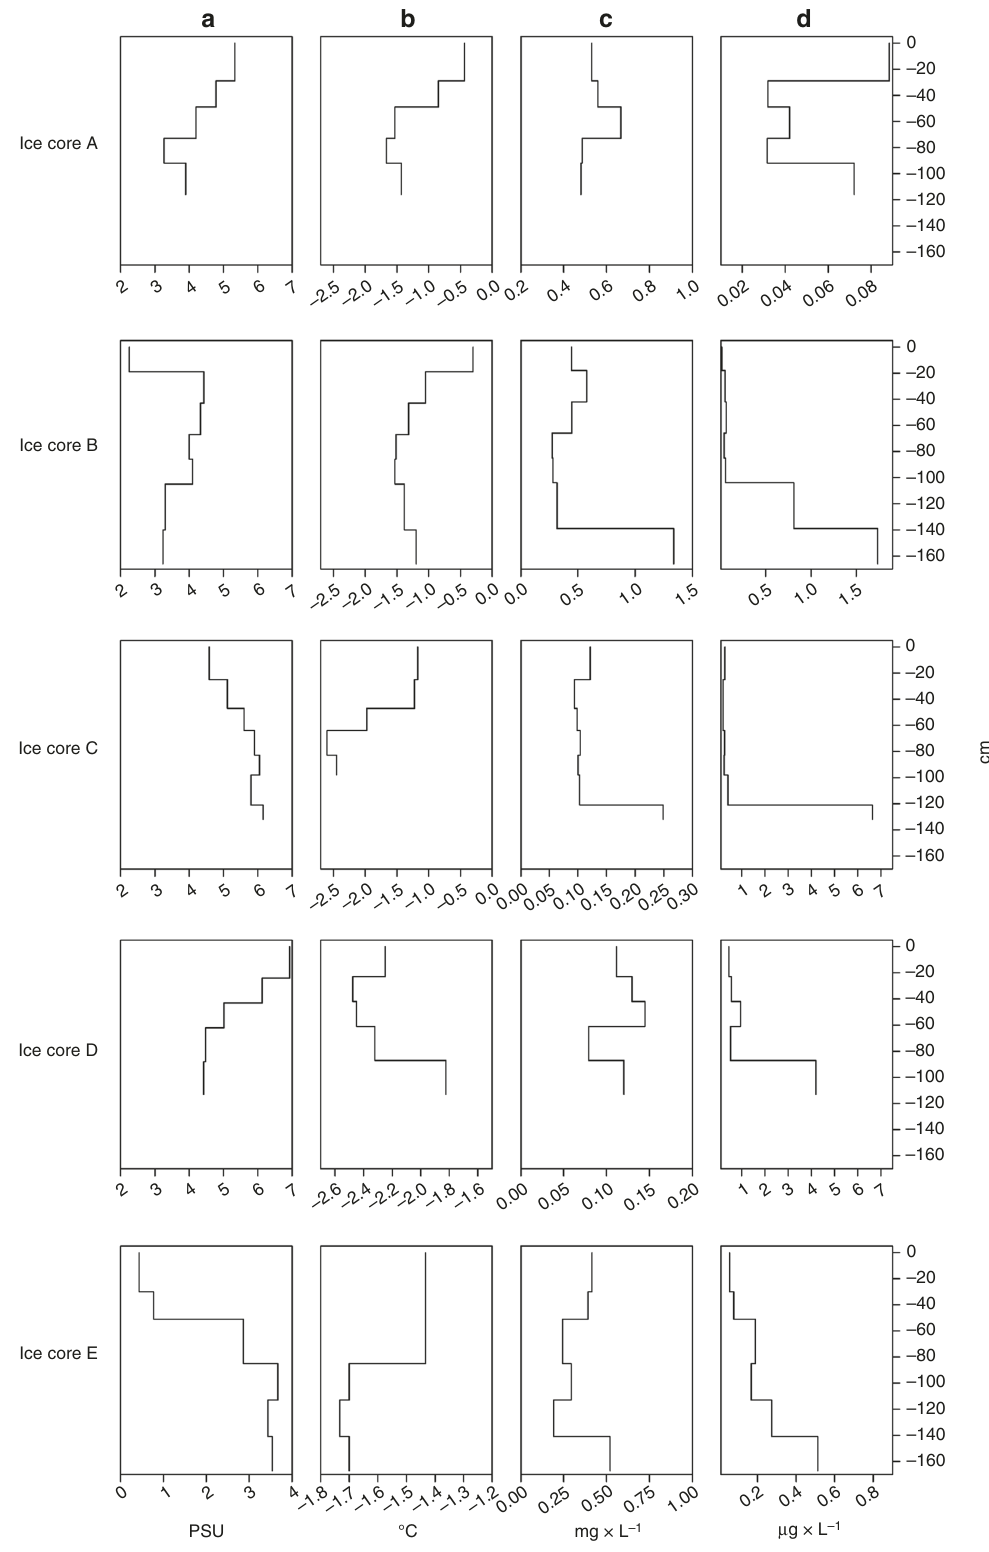
Fig. 4 Vertical distribution of ancillary data in sea ice cores. a Refers to the salinity (PSU), b refers to temperature (°C), c refers to particulate organic carbon content (POC; mg×L − 1 ) and d refers to chlorophyll a concentration ( µ g×L − 1 ) for each core. Steps indicate the sampling horizons taken for each